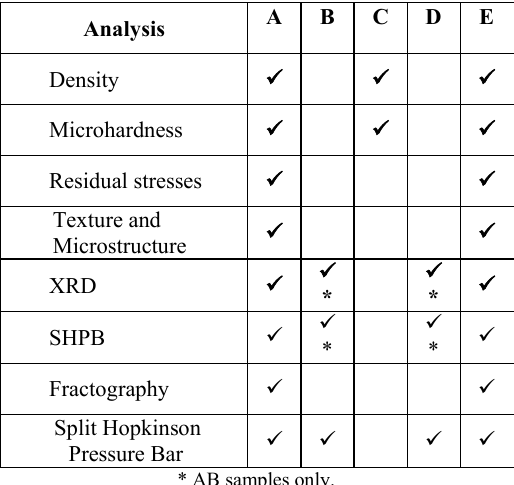
Table 1. Analyses performed on the different